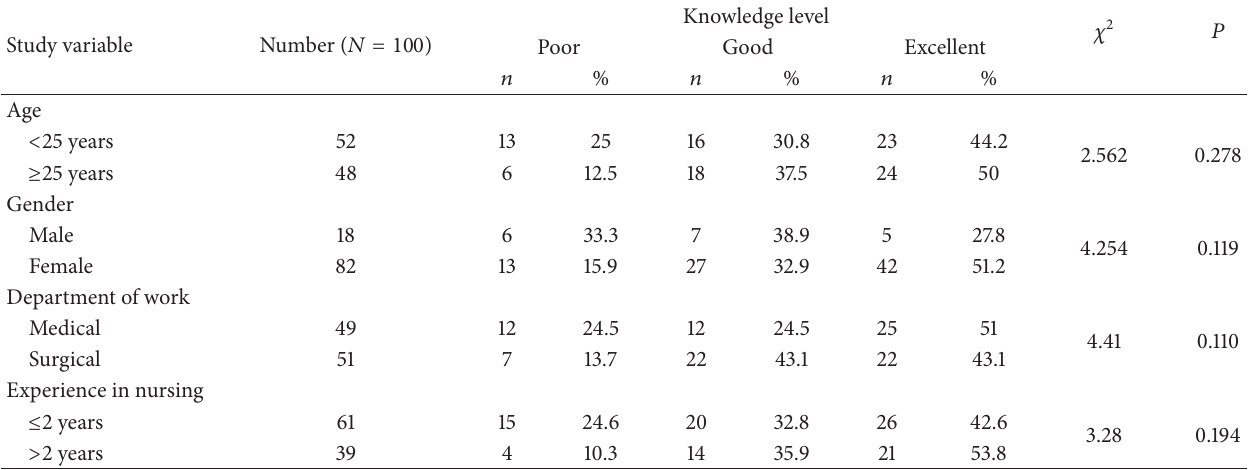
Table 2: Healthcare waste management knowledge of nurses according to their age, gender, department of work, and nursing experience. Study variable